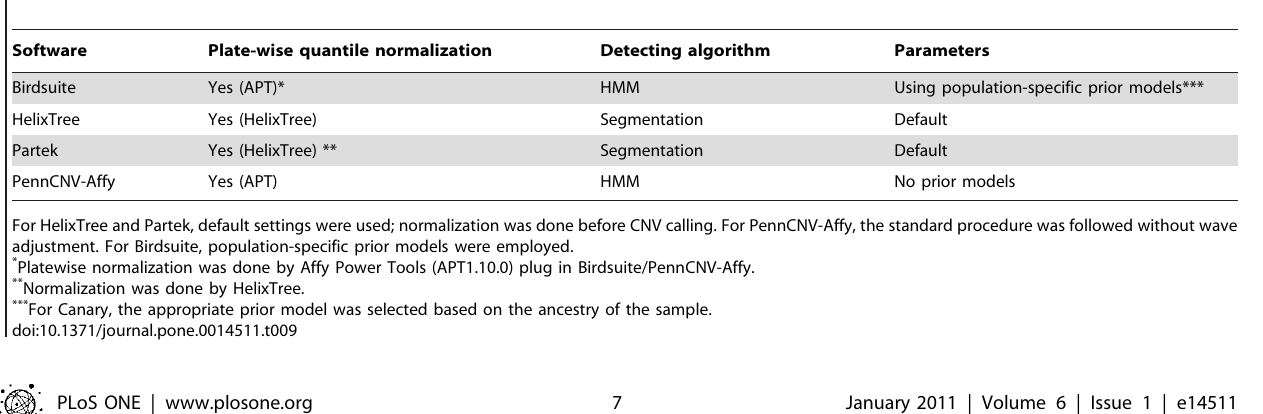
Table 9. Settings used for each of the four software suites.